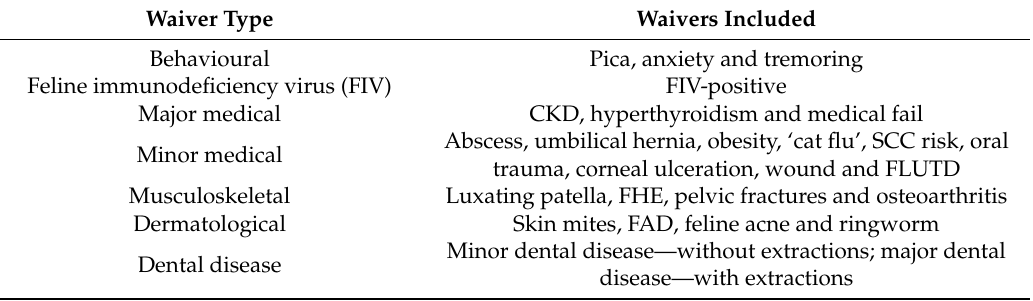
Table 2. Categorisation of waivers from Table 1 into seven groups (‘waiver type’) for the purposes of statistical analysis. The total number of waiver types included for this study is summarised in Table 3.